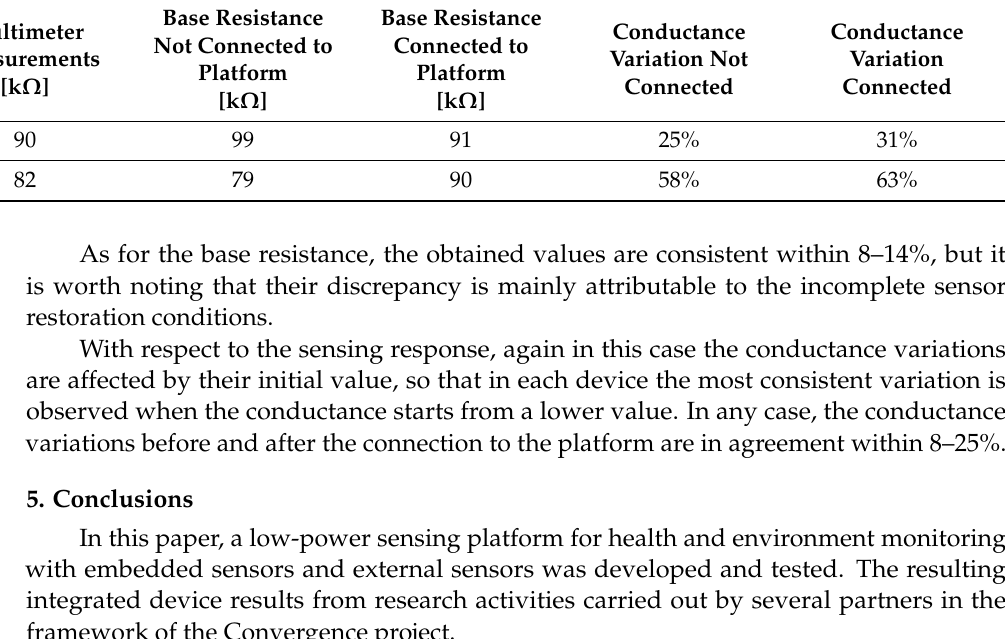
Table 12. Summary of the main electrical parameter checked after the connection to the CEA-LETI platform. Multimeter